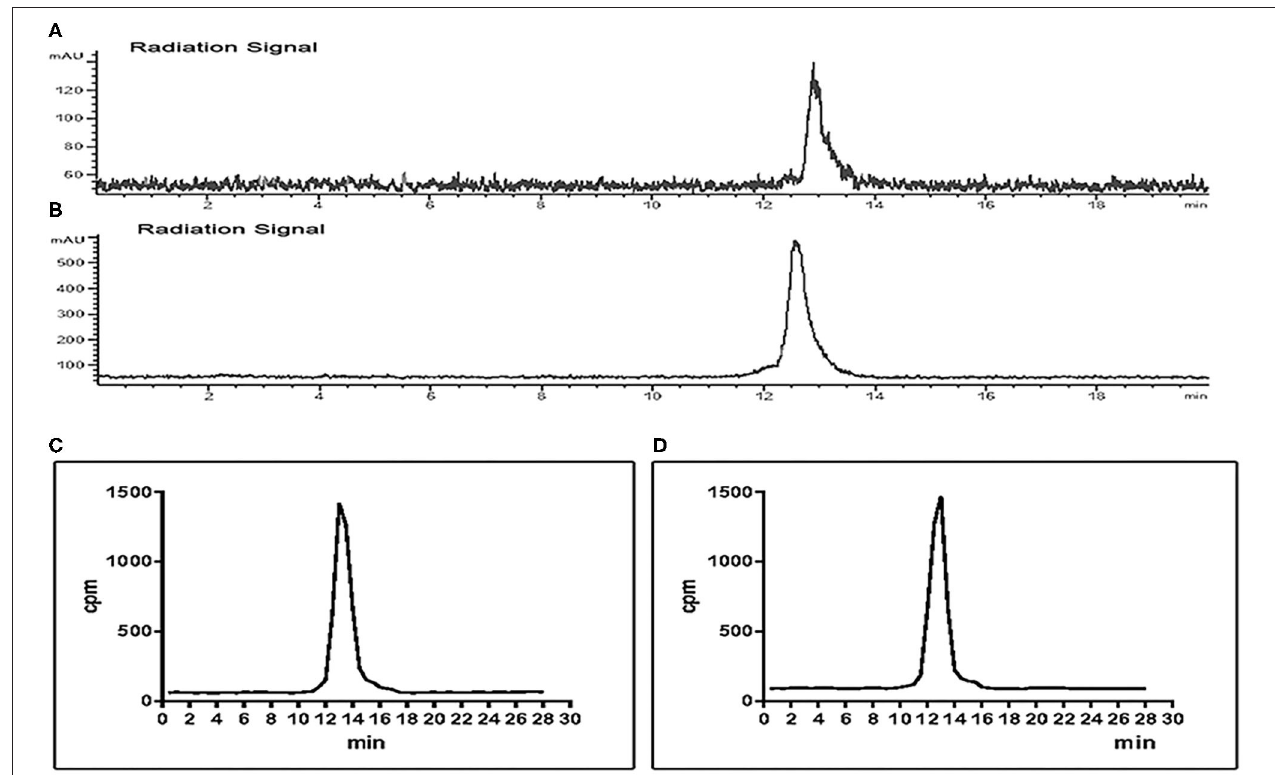
FIGURE 4 | Chiral radio-HPLC of [ 18 F]-AIF-NOTA-NSC-GLU ( C,D test tube method*). ( A ) [ 18 F]-AIF-NOTA-NSC-GLU-injected solution. ( B ) [ 18 F]AlF-NOTA-NSC-GLU, co-cultured with fetal bovine serum for 2h. ( C ) Post-injection of [ 18 F]AlF-NOTA-NSC-GLU. ( D ) Plasma collected at 1h post-injection of [ 18 F]AlF-NOTA-NSC-GLU. * Test tube method was introduced as previously described ( Liu et al., 2019). HPLC, high-performance liquid chromatography.